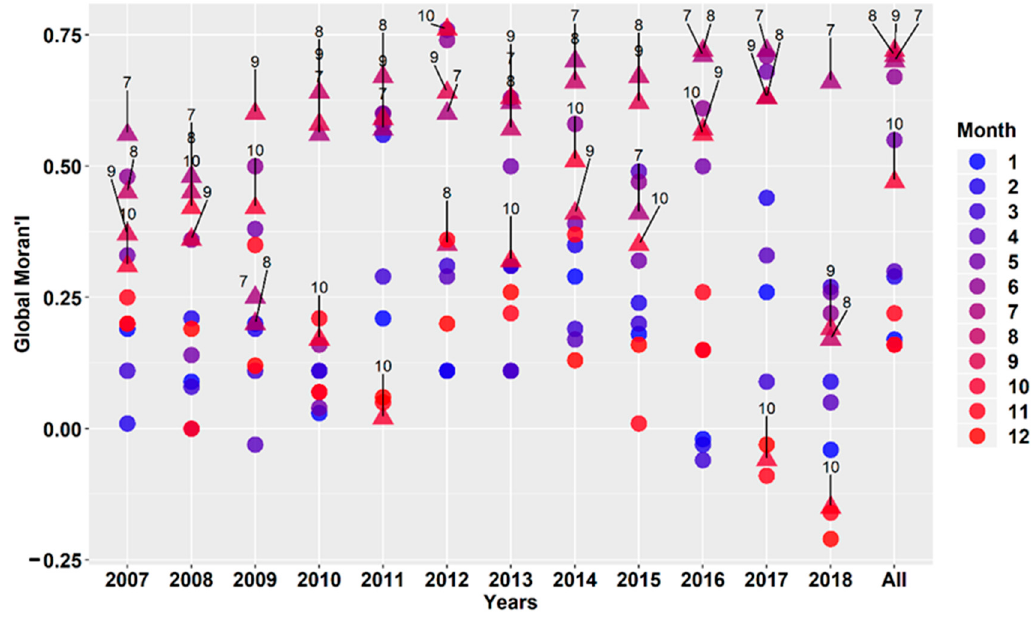
Figure 4. Monthly Global Moran’I variations from 2007 to 2018 in PRD. Colorful solid dots indicate different months in each year and digits hanging above the solid dots mark the high O 3 concentration months (7–10). “All” is O 3 average throughout all the years.